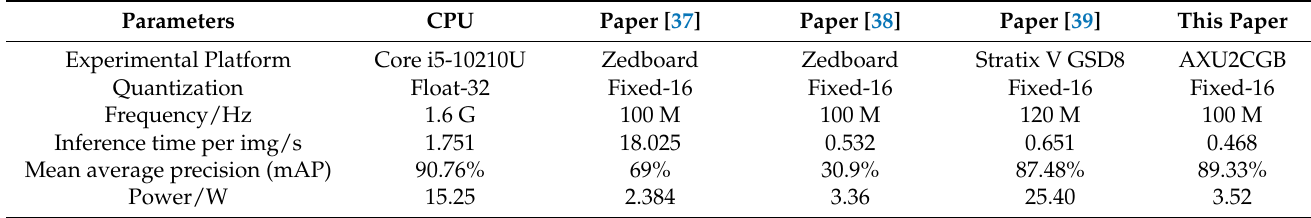
Table 2. Comparison of the different